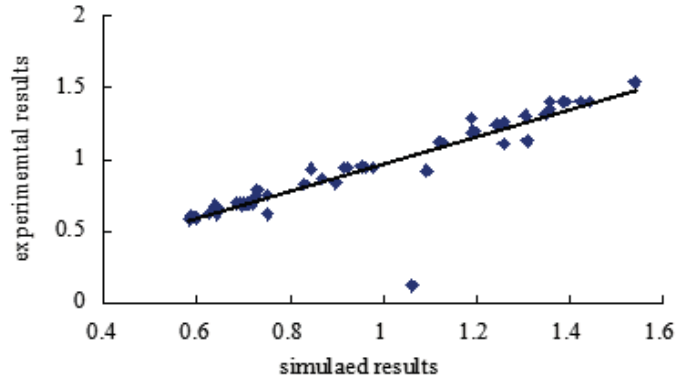
Figure 6. Regression plot (experimentally vs. predicted) using ANN model.